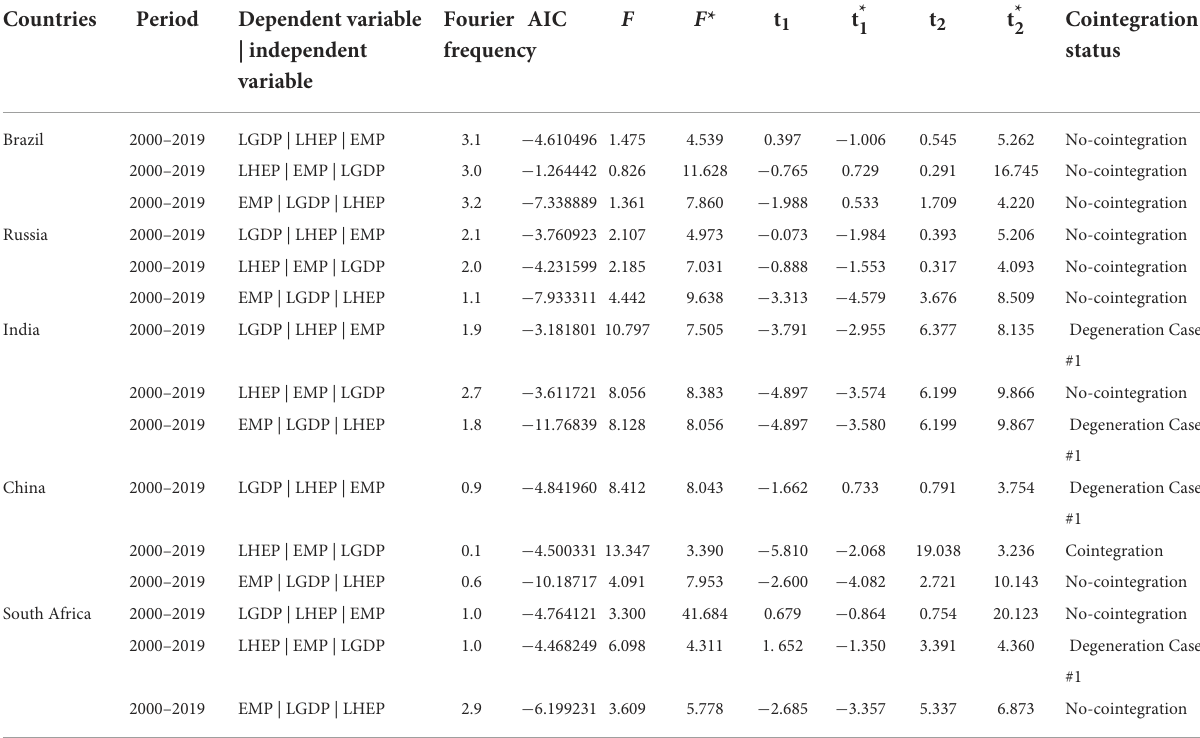
TABLE 6 Cointegration analysis.